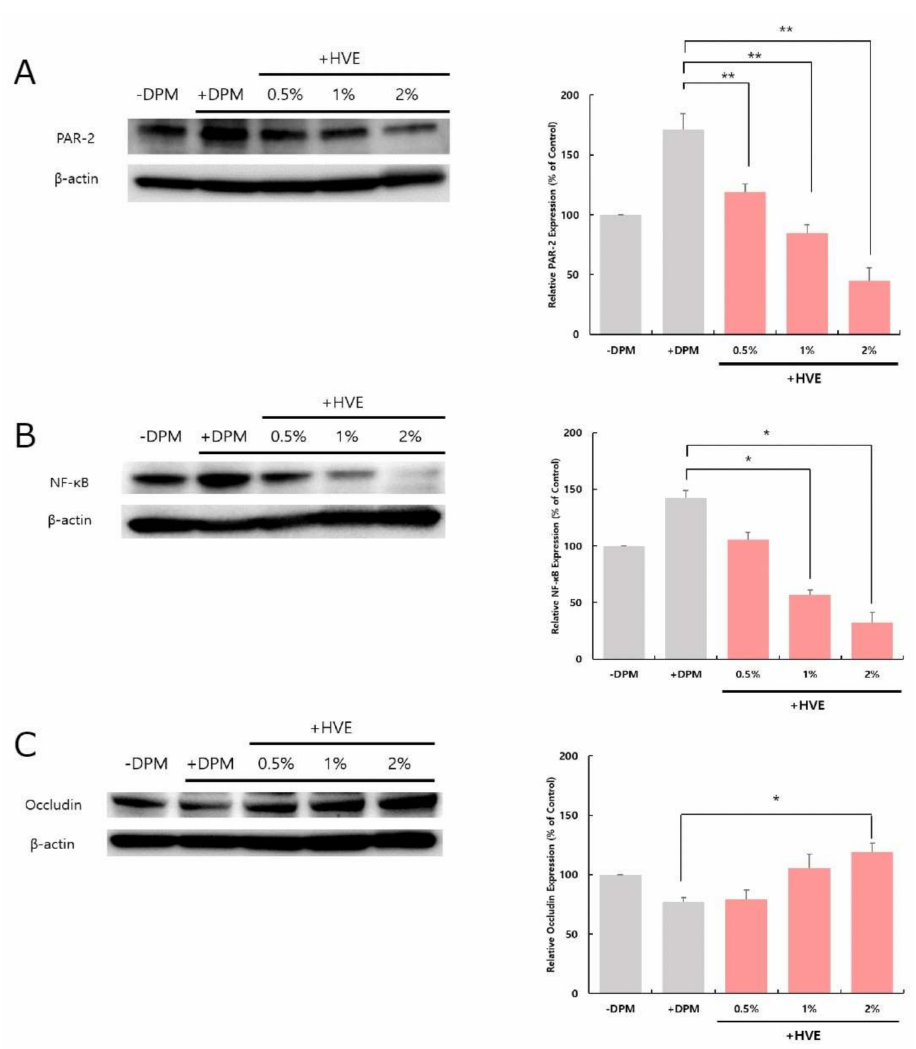
Figure 2. HVE supported HaCaT cells to recover from the DPM-induced damage state. The levels of PAR-2 ( A ) and NF- κ B ( B ) were increased by DPM treatment (25 µ g/mL in the media), but HVE could reduce them to or below the normal level. On the contrary, the level of Occludin ( C ) was decreased by DPM, but returned to the normal level by HVE. Densitometry data were normalized by β -actin and the significance was analyzed using a paired Student’s t -test. * p < 0.05; ** p <